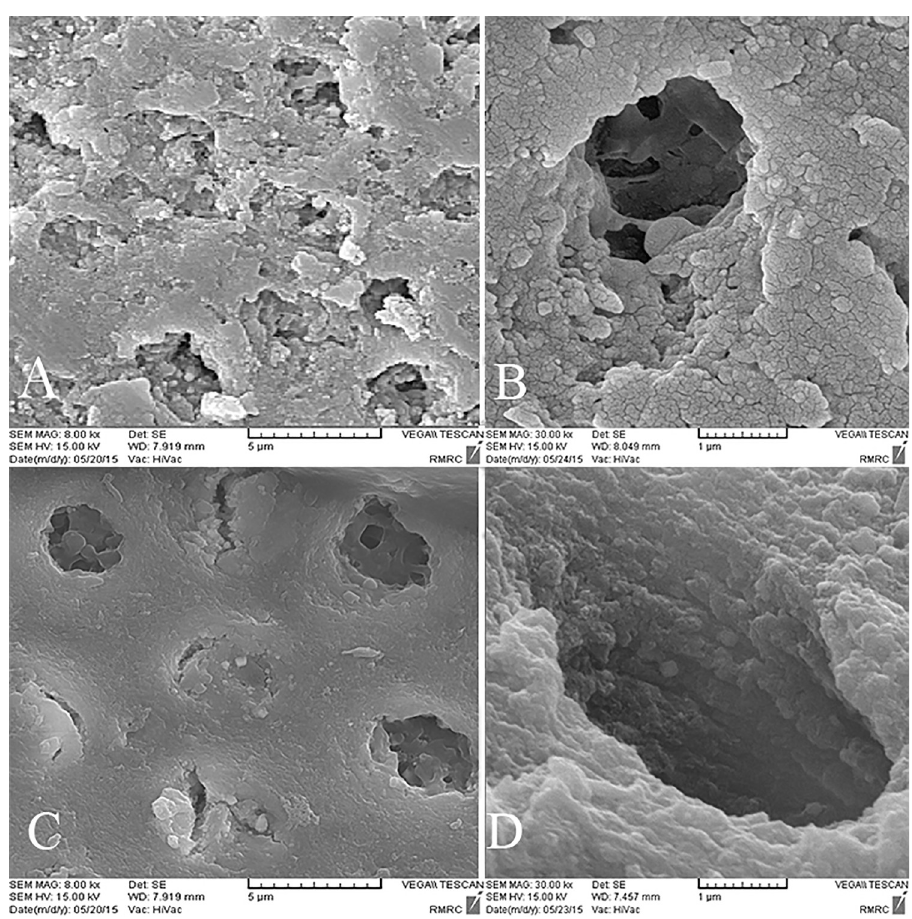
Fig 5. SEM images of the SDF group. A,B. Before acidic challenge. C,D. After Acidic challenge.